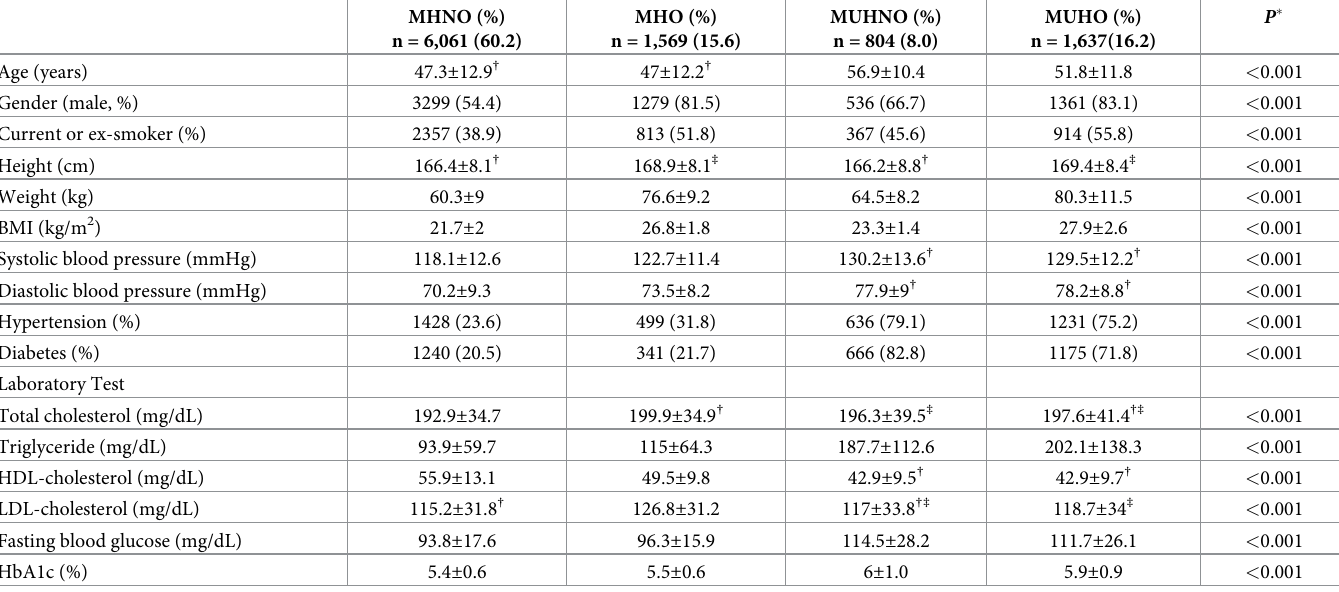
Table 2. Comparison of variables between the groups divided according to metabolic health and obesity status.